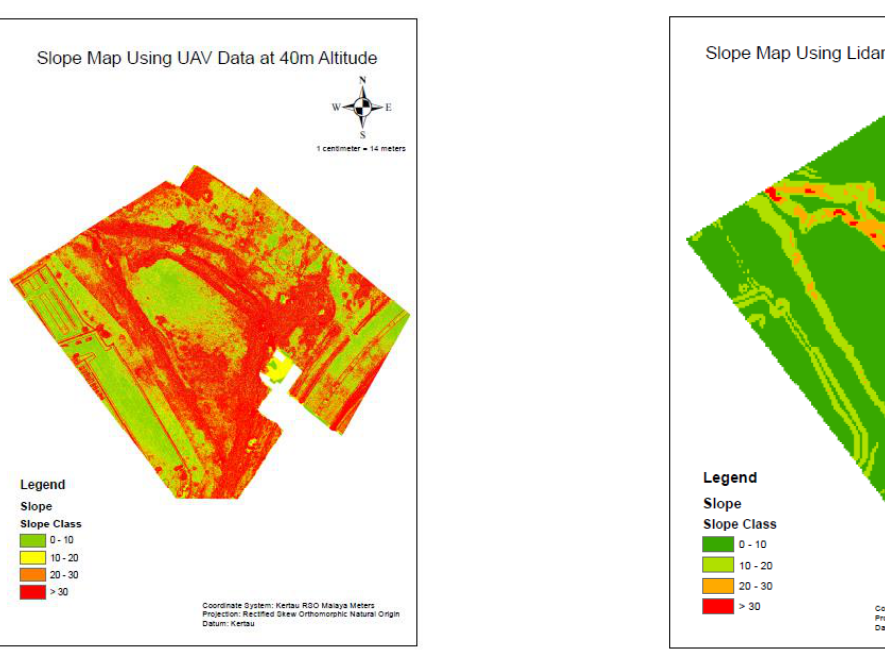
Figure 20. Slope Map Generated Using UAV Data at 40m Altitude